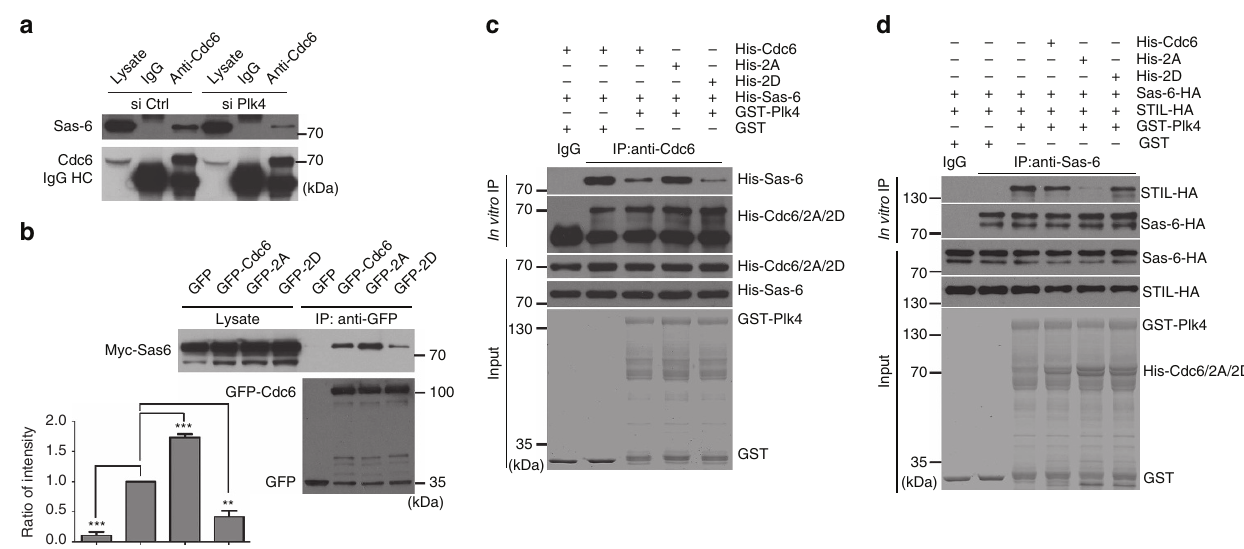
Figure 7 | Cdc6 phosphorylation by Plk4 disrupts the Cdc6-Sas-6 interaction and facilitates Sas6-STIL complex formation. ( a ) The interaction between Cdc6 and Sas-6 is impaired by Plk4 depletion in cells. The whole cell extract of HEK 293 T cells transfected with control siRNA or Plk4 siRNA was immunoprecipitated with a Cdc6 antibody, and probed with Cdc6 and Sas-6 antibodies. ( b ) Cdc6 phosphorylation inhibits the interaction between Cdc6 and Sas-6 in cells. HEK293 cells co-transfected with Myc-tagged Sas-6 and GFP-tagged Cdc6, 2A or 2D mutant were immunoprecipitated with a GFP antibody, and analysed by western blotting using Myc and GFP antibodies. Quantitation of the interaction between Sas-6 and Cdc6 WT, 2A or 2D mutant was analysed from three independent experiments. The relative interaction between Sas-6 and Cdc6 was normalized to the immunoprecipitated Cdc6 by ImageJ. The interaction between Myc-Sas-6 and GFP-Cdc6 WTwas arbitrarily set at an intensity of 1.0. ( c ) Cdc6 phosphorylation inhibits the interaction between Cdc6 and Sas-6 in vitro . His-tagged Cdc6, 2A or 2D mutant protein transcribed and translated in vitro was incubated with or without Plk4 kinase in the presence of in vitro transcribed and translated His-Sas-6 in kinase reaction buffer. His-Cdc6 was then immunoprecipitated by Cdc6 antibody, and the bound proteins were analysed with Cdc6 and Sas-6 antibodies. The loadings of GSTand GST-tagged Plk4 proteins are shown by Coomassie blue staining. ( d ) Cdc6 phosphorylation by Plk4 suppresses the inhibition of Cdc6 on Sas6-STIL complex formation. HA-tagged Sas-6 protein transcribed and translated in vitro was incubated with indicated purified proteins in the presence of in vitro transcribed and translated HA-tagged STIL in kinase reaction buffer. HA-Sas-6 was then immunoprecipitated by Sas-6 antibody, and the bound proteins were analysed with Sas-6 and STIL antibodies. The loadings of GST, GST-tagged Plk4, His tagged Cdc6, 2A and 2D mutant proteins are shown by Coomassie blue staining. The statistical data in b is presented as means ±